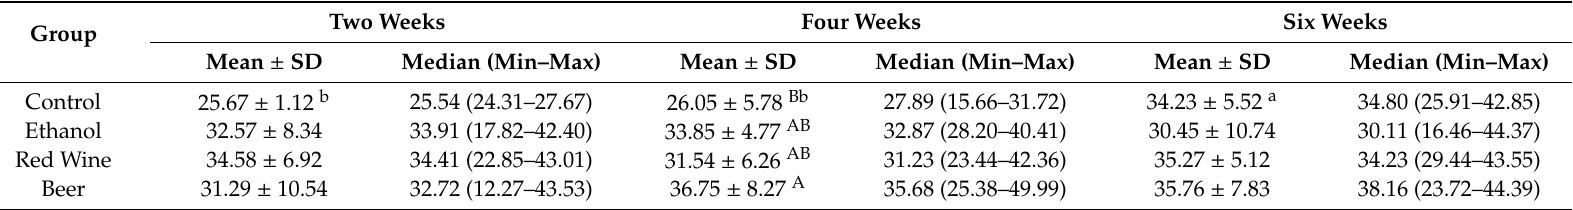
Table 6. Catalase (CAT) activity (per mg of protein) in the groups of experimental rats stratified by a group and experiment duration.